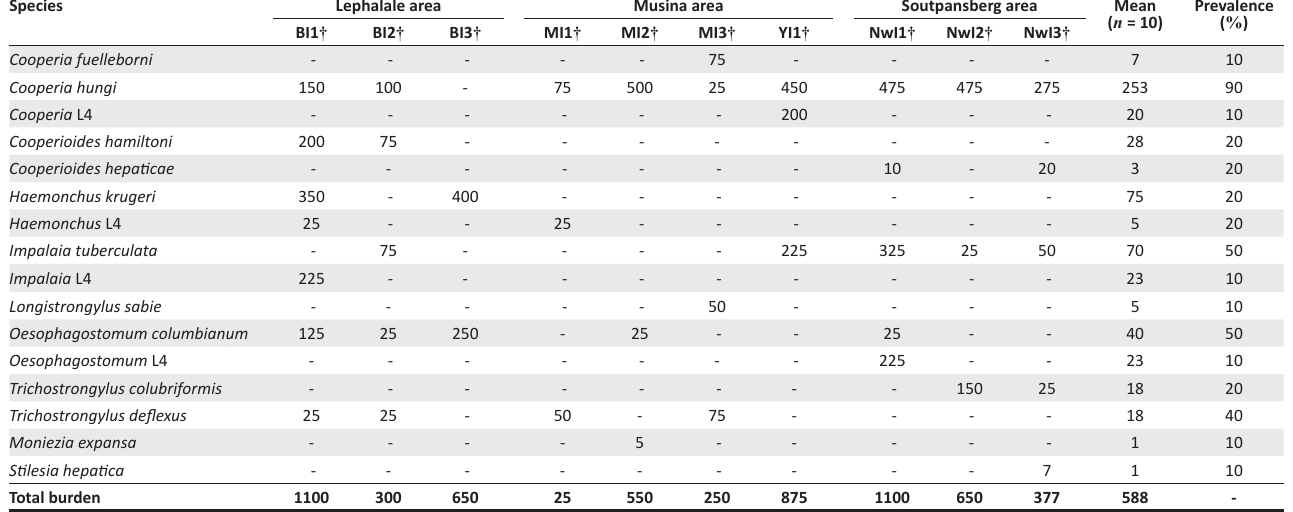
TABLE 2: Total helminth burdens of examined impala. Species Lephalale area